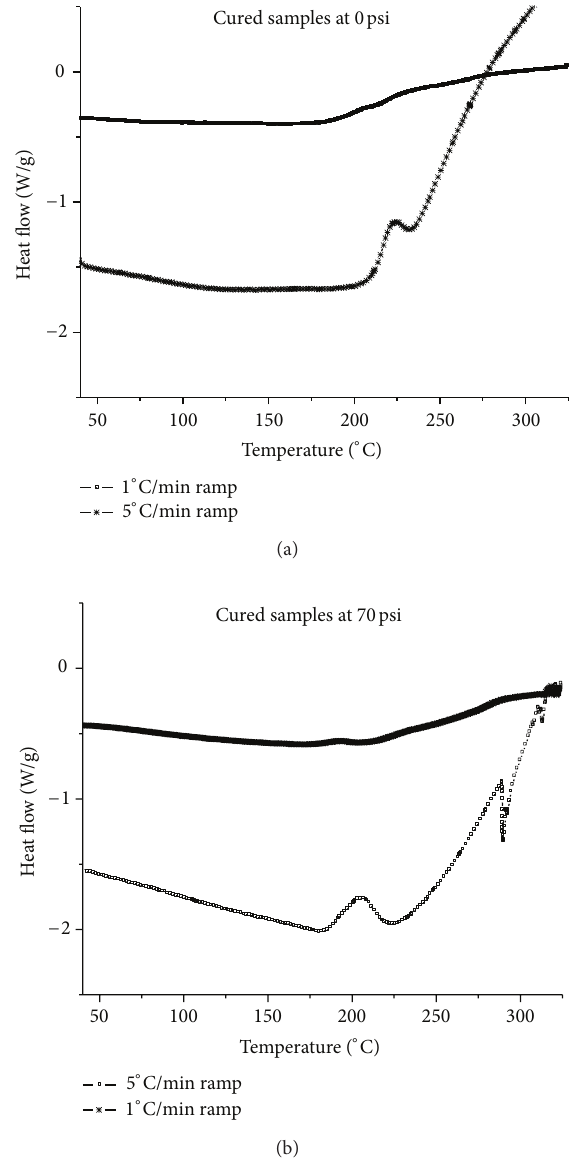
Figure 5: DSC scans at 1 and 5 ∘ C/min for different pressure cases ((a) 0psi; (b)